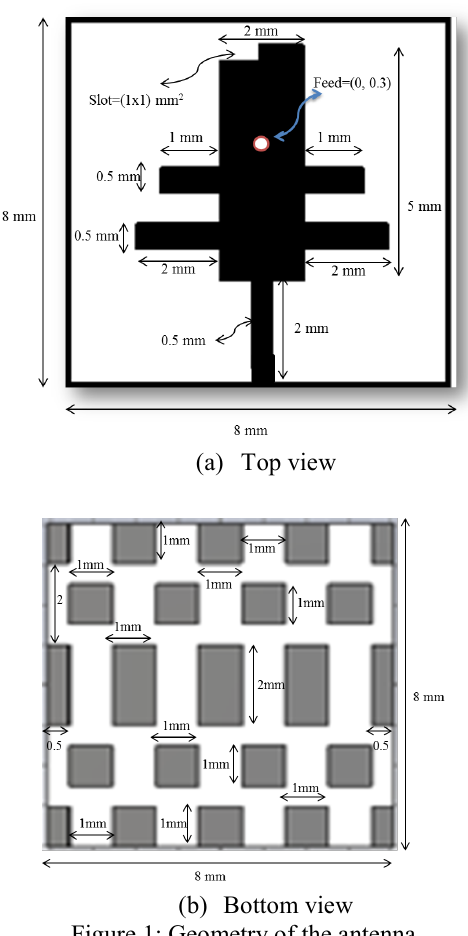
Figure 1: Geometry of the antenna